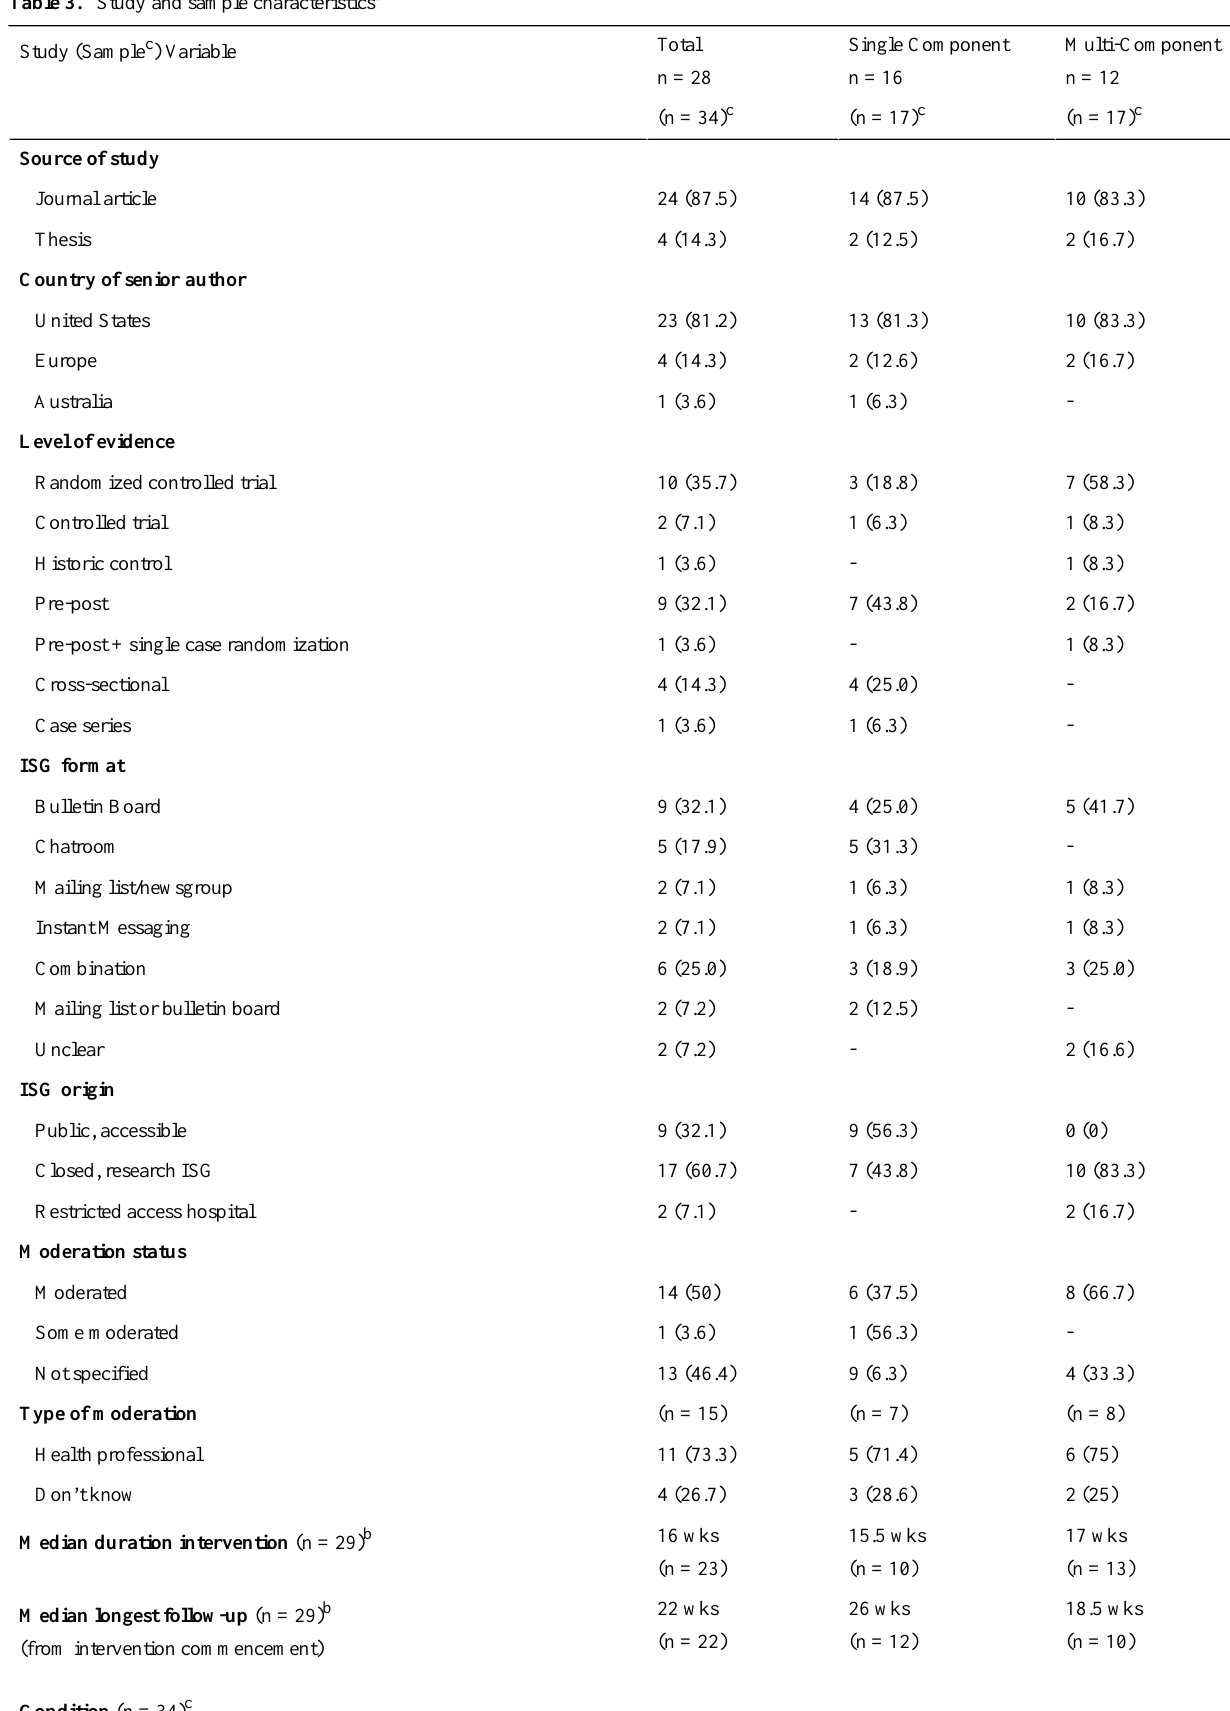
Table 3. Study and sample characteristics